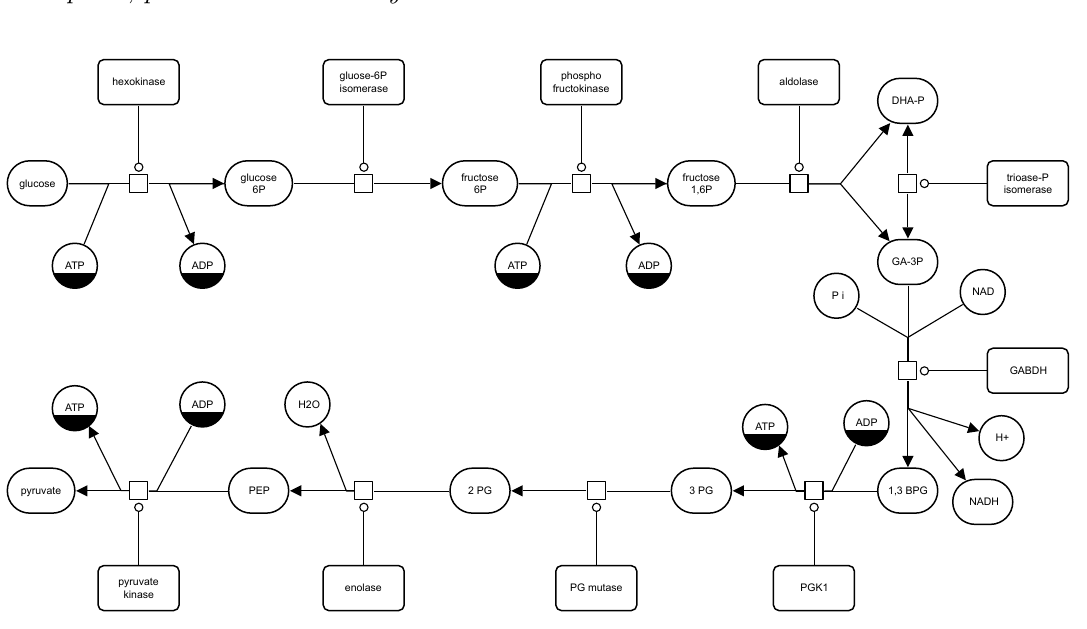
Figure A.1: Glycolysis. This example illustrates how SBGN can be used to describe metabolic